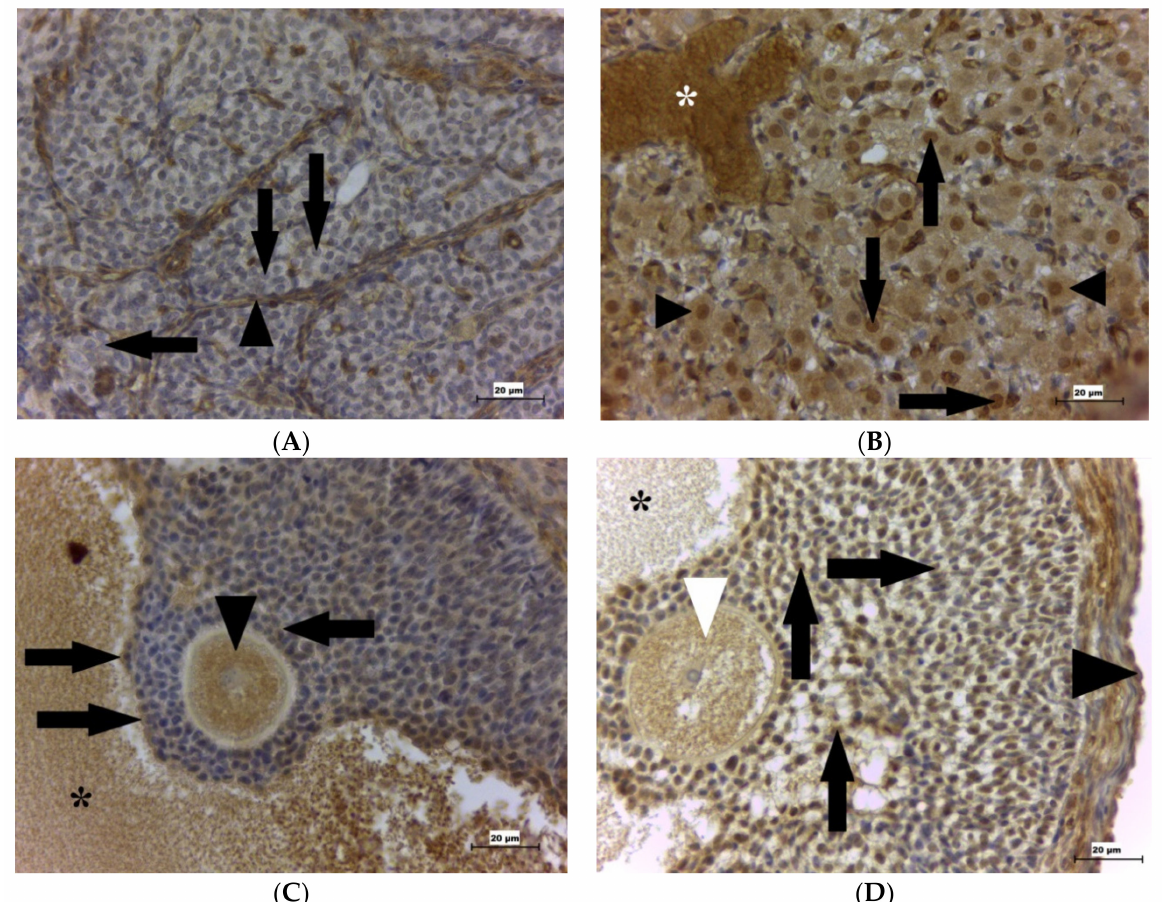
Figure 2. GPx4 presence in the rat ovary. ( A ) Shows the rat corpus luteum on D1. Immunohistochemical analysis shows no positivity of the nuclei and cytoplasm of the younger growing granulosa-lutein cells (arrows) for GPx4. Theca-lutein cells (arrowhead) are positive for the examined enzyme. ( B ) Shows rat corpus luteum on D1. Immunohistochemical analysis shows cytoplasmic (arrowheads) and nuclear (arrows) positivity of matured granulosa-lutein cells, and erythrocytes (white asterisk) for GPx4. ( C ) Shows the rat Graafian follicle with cumular cells on D1. Immunohistochemical analysis shows the positive cytoplasm of the oocyte (arrowhead) and cumular cells (arrows) and positive follicular fluid (asterisk) for GPx4. ( D ) Shows the rat atretic Graafian follicle with cumular cells on D5. Immunohistochemical analysis shows the positive cytoplasm of the oocyte (white arrowhead) and cumular cells (arrows), positive follicular fluid (asterisk), and germinal epithelium (black arrowhead) for GPx4. Scale bar = 20 µ m. GPx4 is glutathione peroxidase 4; D1 is the first day of pregnancy; D5 is the fifth day of